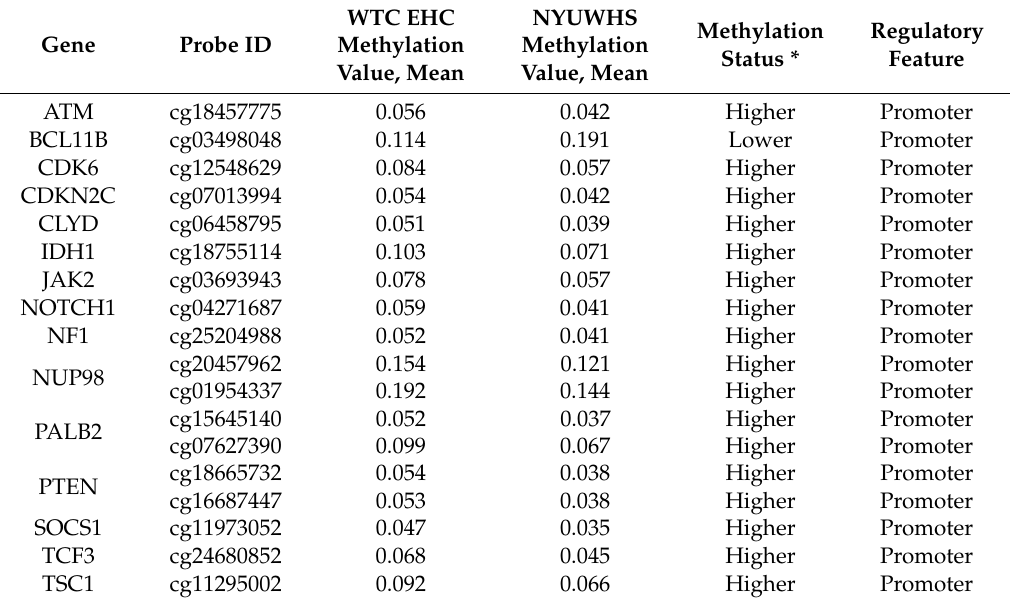
Table 3. Methylation values of known tumor suppressor genes in the WTC-exposed (WTC EHC) cancer-free subjects compared to the unexposed cancer-free subjects (NYUWHS).